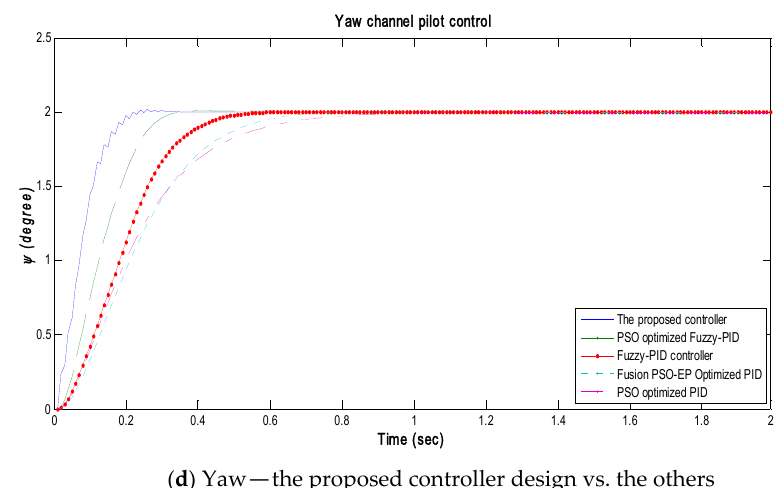
( d ) Yaw — the proposed controller design vs. the others Figure 7. Yaw channel pilot control. ( a : top left) Fitness function of the proposed controller design. ( b : top right) PID parameter in 3-Dimensions convergence space. ( c : middle) The minimum of IAE(e) and IAE(de) in 2-Dimensions. ( d : bottom) Controllers of the yaw angle response.